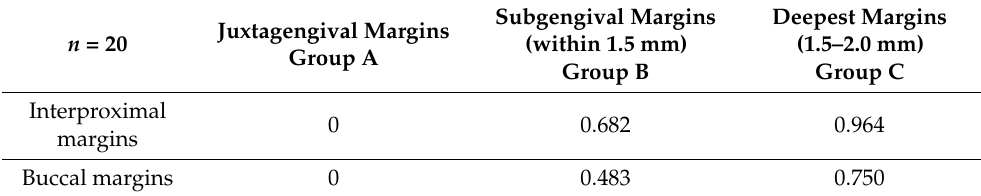
Table 1. Statistical results for the mean distance of the prepared root that cannot be detected with the digital impression compared to the conventional one.